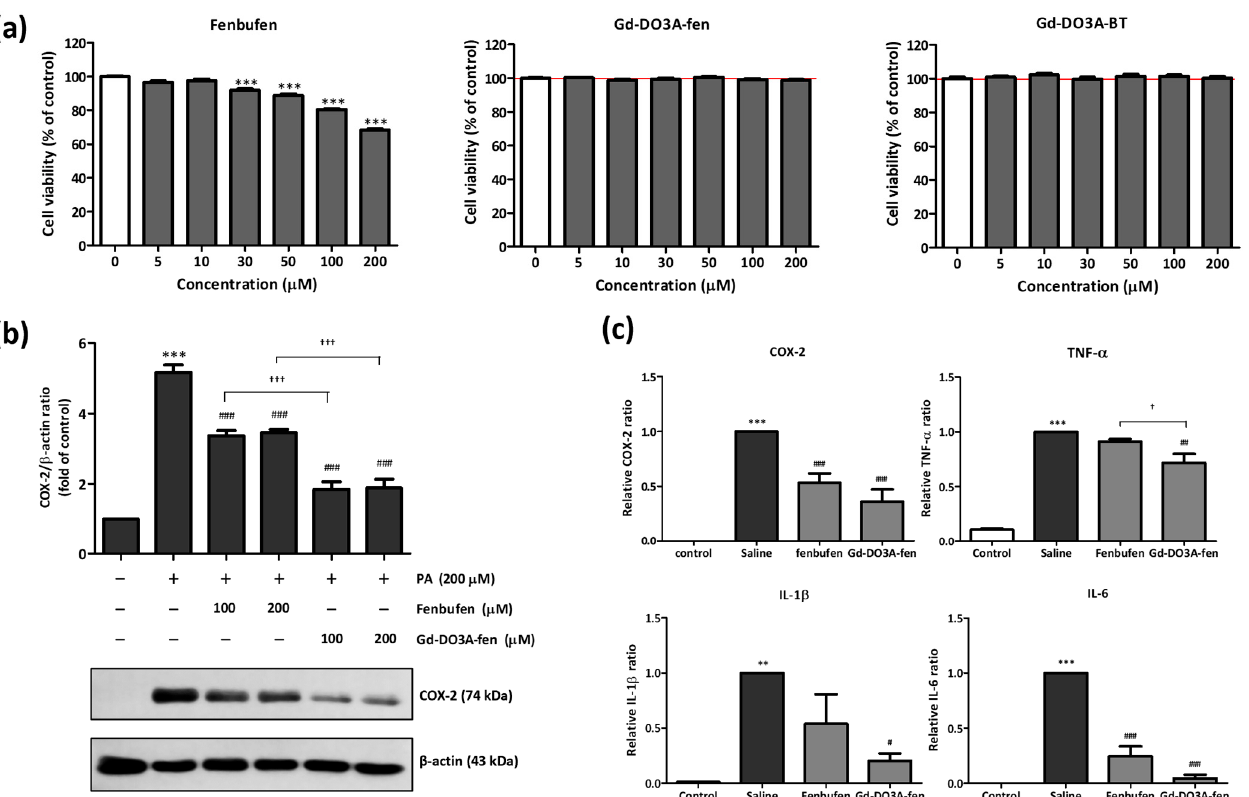
Figure 4. Antiinflammatory effect of drugs on PA-induced inflammation in C2C12 cells and in a turpentine oil-induced inflammation mouse model. ( a ) Effect of drugs on the viability of C2C12 cells (*** p < 0.001 vs. nontreated control; n = 3). ( b ) The protein levels of COX-2 analyzed in total cell lysates by Western blotting. The bar graph represents the average densitometry values relative to β -actin (*** p < 0.001 vs. nontreated control, ### p < 0.001 vs. PA, ††† p < 0.001 vs. fenbufen; n = 3). ( c ) Comparison of the mRNA expression levels of the proinflammatory enzyme and cytokines in the inflammation-induced mouse model injected with turpentine oil. The saline group was intravenously injected saline instead of drug in turpentine oil-induced model. The control group was injected with saline instead of turpentine oil. The bar graph represents the relative ratio of saline (** p < 0.05, *** p < 0.001 vs. nontreated control, # p < 0.01, ## p < 0.05, ### p < 0.001 vs. PA, † p < 0.01 vs. fenbufen; n = 3).